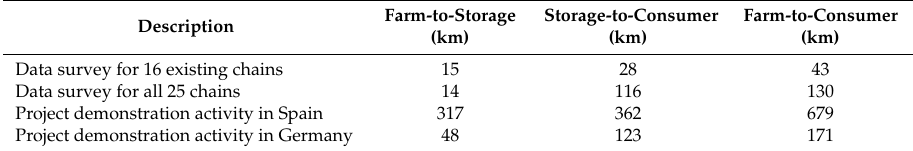
Table 4. Average transport distances (round trip) for different PtE information sources. Description